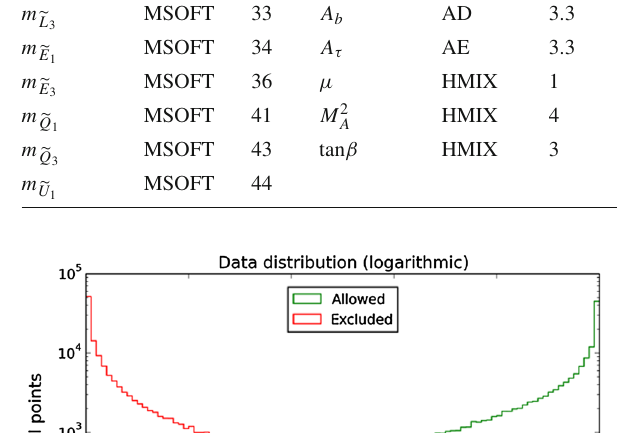
the points is classified correctly (the allowed points pile-up at a classifier output of 1 . 0, while the excluded points pile- up at a classifier output of 0 . 0), some of the points fall into the categories of false positives or false negatives. A per- fect classification is therefore not possible, and one has to make cuts in this diagram to make the classification